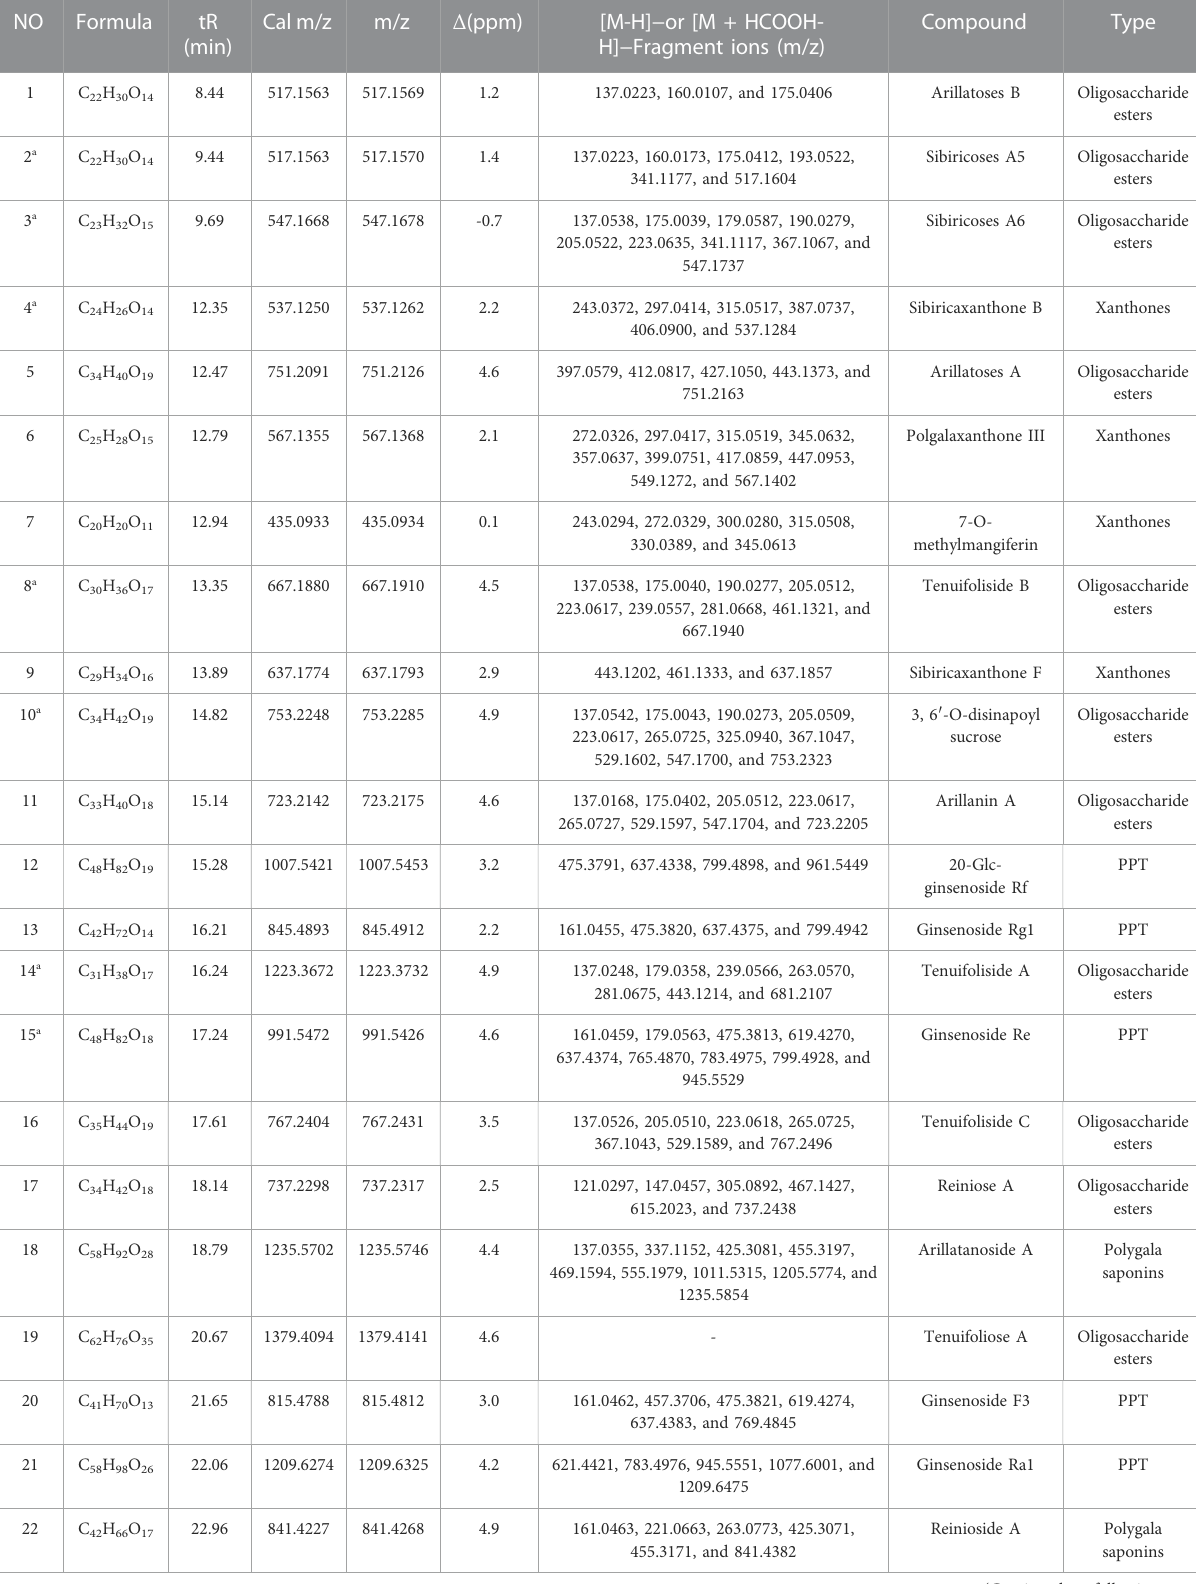
TABLE 2 Chemical composition analysis of the “ ginseng – polygala ” drug pair by UHPLC-QTOF-MS in the negative ion